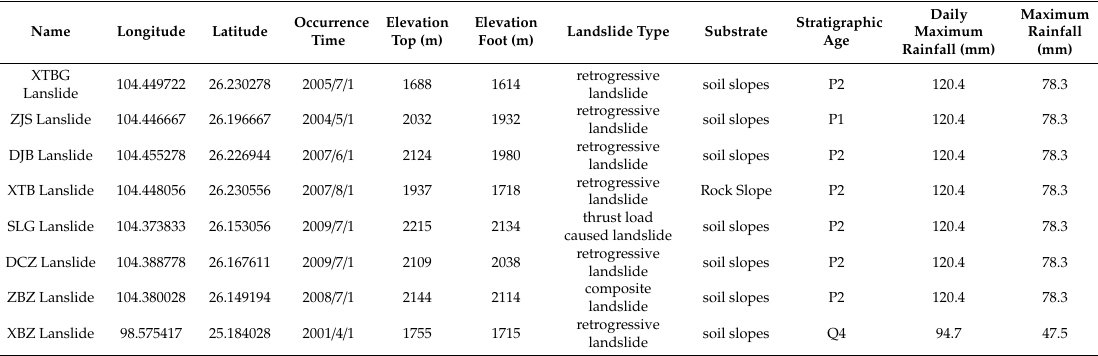
Table 1. Information on some landslide disasters in the area of the Three Parallel Rivers.